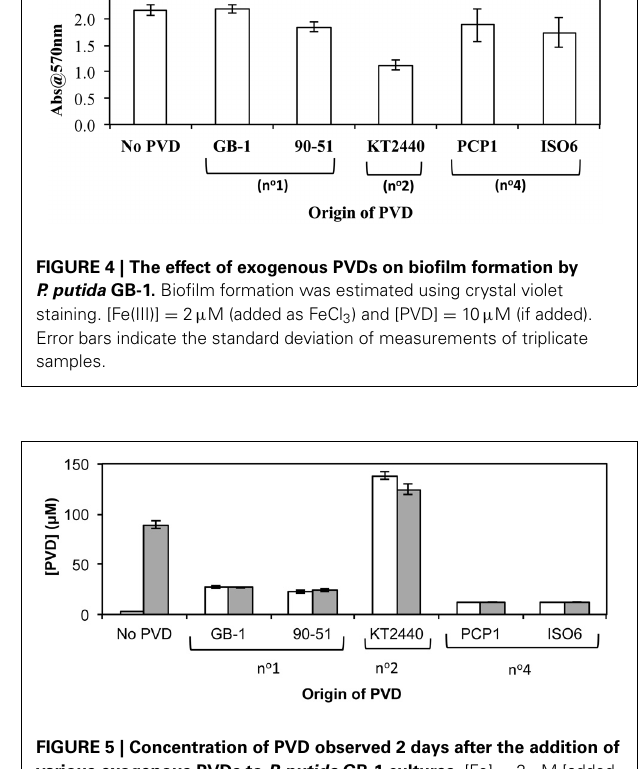
FIGURE 5 | Concentration of PVD observed 2 days after the addition of various exogenous PVDs to P. putida GB-1 cultures. [Fe] = 2 μ M [added as FeCl 3 (dark bars) or FeSO 4 • 7H 2 O (light bars)] and added [PVD] = 10 μ M (if added). The exogenous PVDs were: siderotype n ◦ 1, PVDGB-1 and PVD CFML90 − 15 ; siderotype n ◦ 2, PVD KT2440 ; siderotype n ◦ 4, PVD PCP1 and PVD ISO6 . Error bars indicate the standard deviation of measurements of triplicate